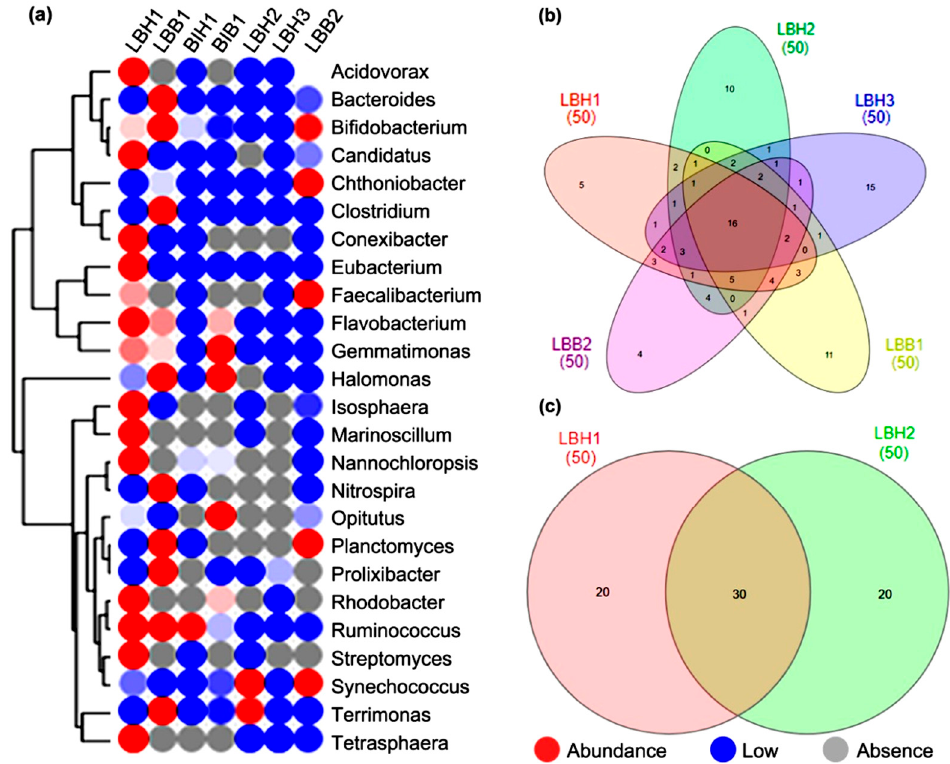
Figure 3. Top hits rank abundance plot comparison based on genus-level for selected healthy and bleached sponges. ( a ) The heat map represents the abundances of annotations of taxonomic richness and evenness on a log scale. ( b , c ) The Venn diagram represents the common and unique genus found in the samples.